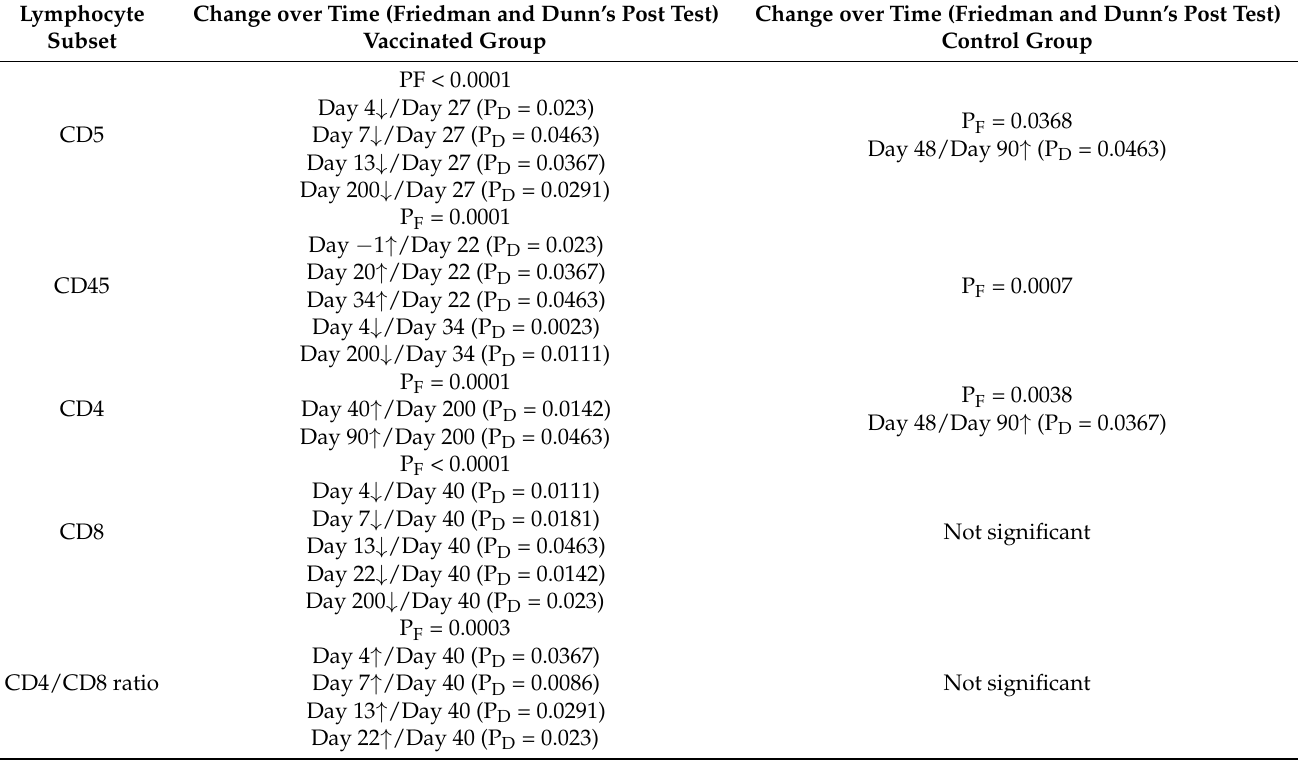
Table A2. Results of the Friedman and Dunn’s post test of lymphocyte subsets after FCV Vaccination I.